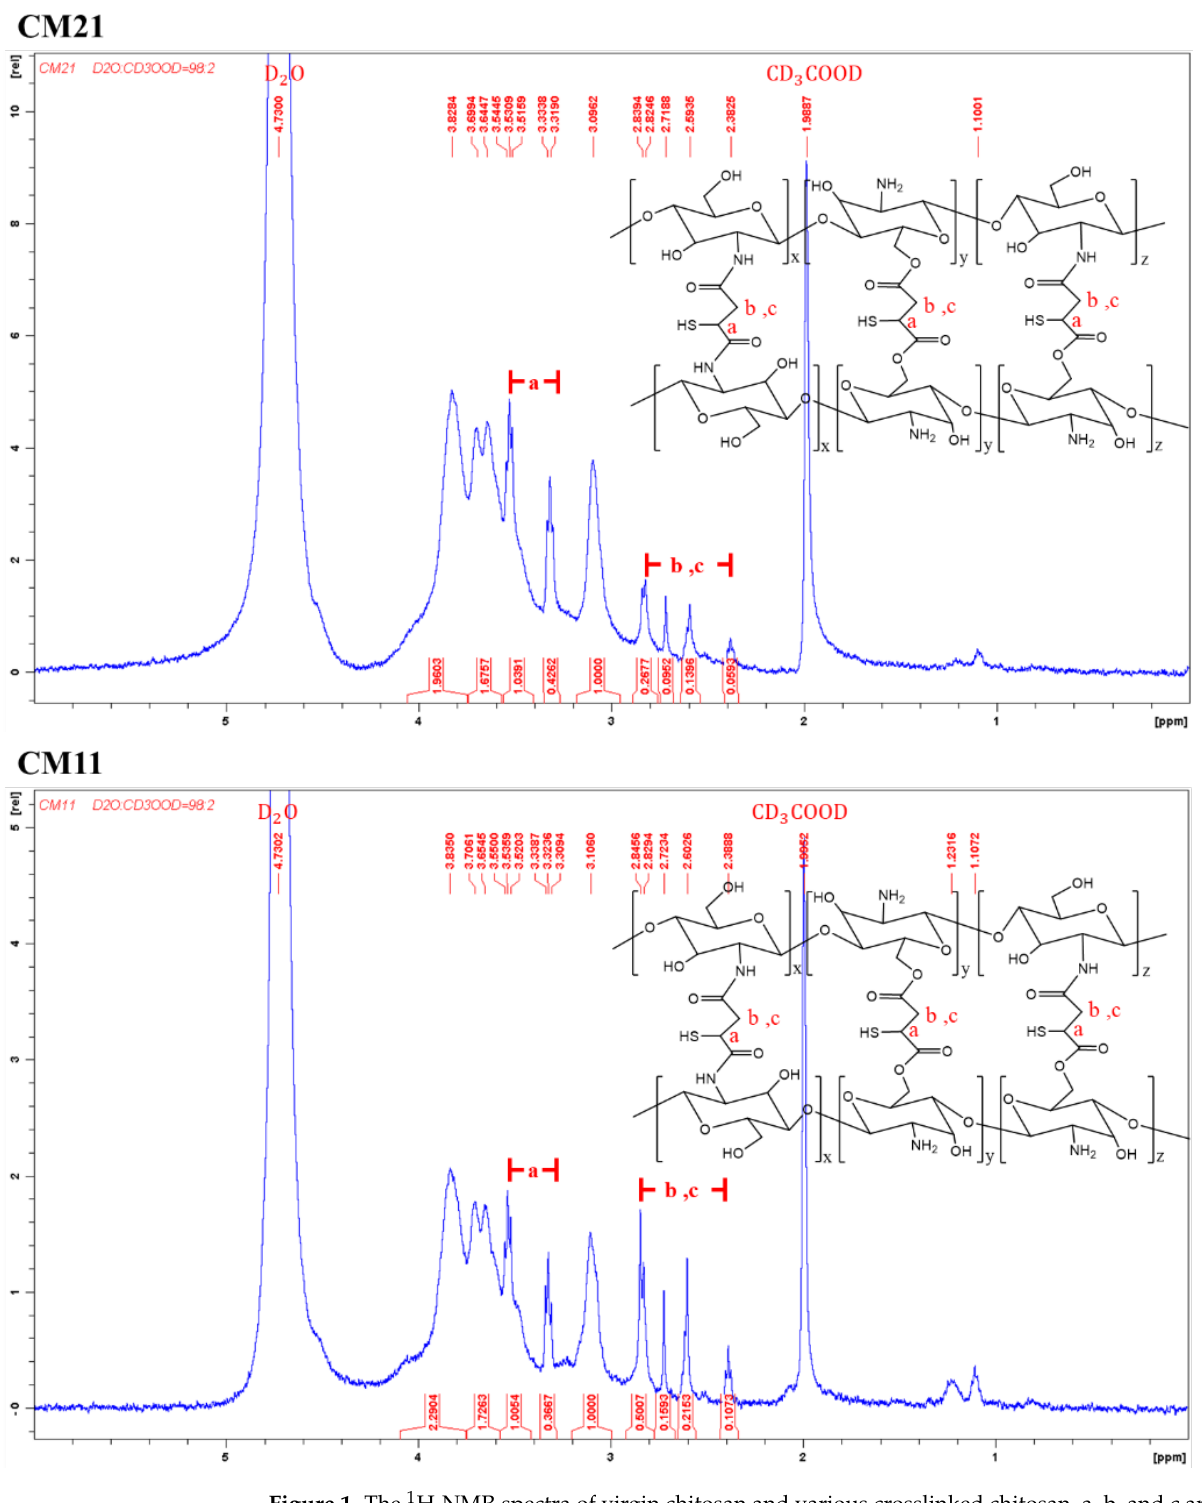
Figure 1. The 1 H-NMR spectra of virgin chitosan and various crosslinked chitosan, a, b, and c are the corresponding H atoms to the indicated peaks.